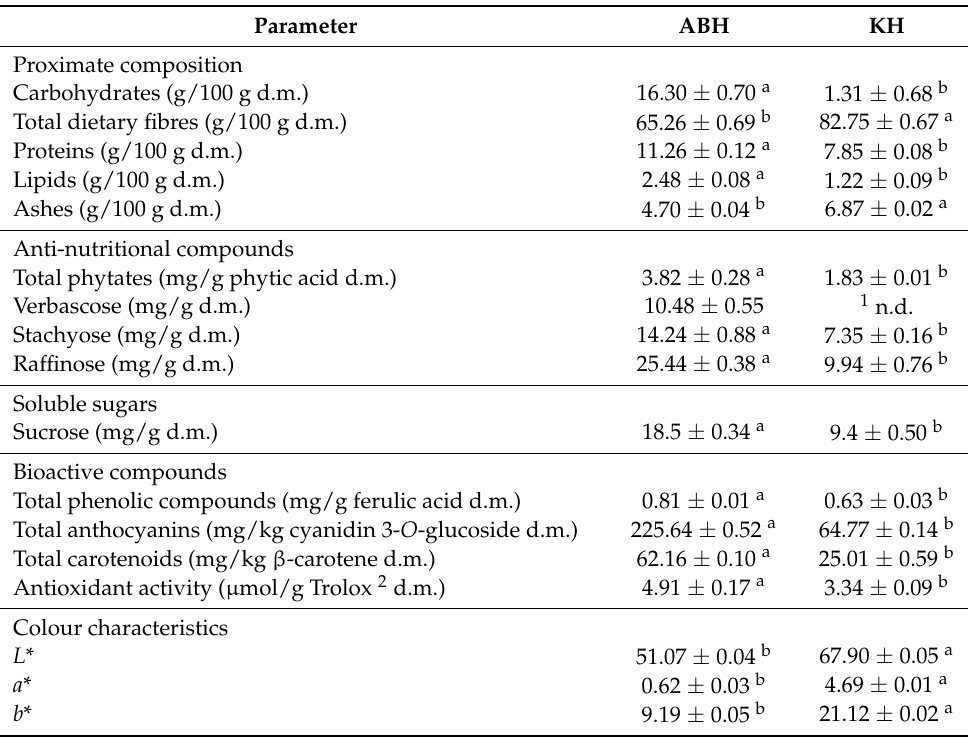
Table 1. Proximate composition, anti-nutritional compounds, bioactive compounds, antioxidant activity, and colour characteristics of Apulian black (ABH) and kabuli (KH) chickpea hull used in the formulation of GF fresh pasta (mean value ± standard deviation; one-way ANOVA was applied). Parameter ABH KH Proximate composition Carbohydrates (g/100 g d.m.) 16.30 ± 0.70 a 1.31 ± 0.68 b Total dietary fibres (g/100 g d.m.) 65.26 ± 0.69 b 82.75 ± 0.67 a Proteins (g/100 g d.m.) 7.85 ± 0.08 b Lipids (g/100 g d.m.) 1.22 ± 0.09 b Ashes (g/100 g